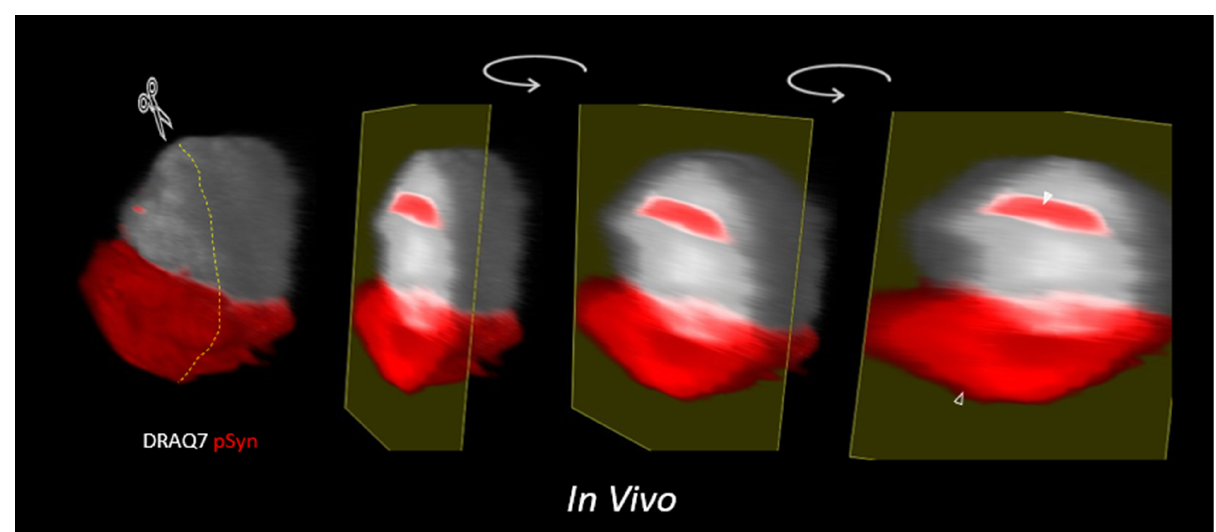
Figure 12. A 3D reconstruction, in silico sectioning (scissors/dots), and 3D rotation of a Z-stack of LSCM optical sections of a single nigral neuron bearing an NII (plain arrow) and an NCI (empty arrow) in a mouse injected 4 months before with 1B fibrils. Phospho-S129 α -Syn: coded in red; DNA/DRAQ7: coded in white. Zone injected with 1B and sampled by LSCM: right substantia nigra.